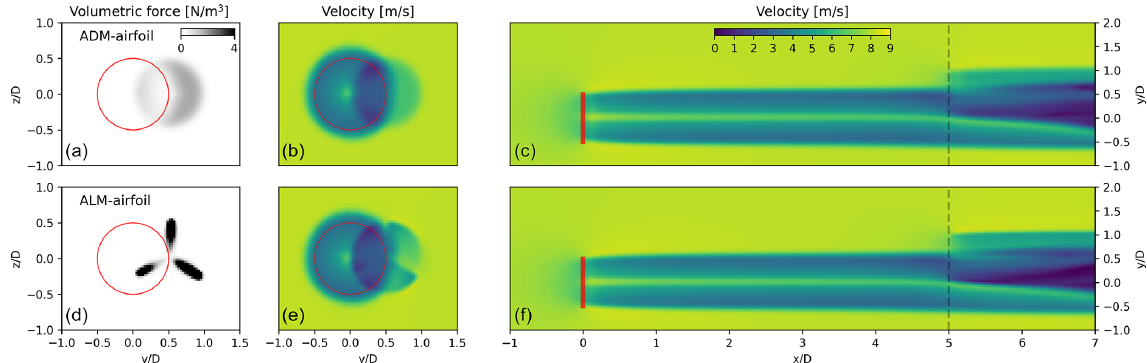
Figure 6. Model comparison for two turbines under uniform velocity inflow conditions of U ∞ = 8ms − 1 , using the ADM-airfoil in WT1 and testing the ADM-airfoil and the ALM-airfoil in WT2: instantaneous force (a, d) and velocity (b, e) in a vertical plane at the WT2 location. The WT1 rotor plane is marked by the red circle. (c, f) Instantaneous velocity in a horizontal plane at hub height, where the WT2 vertical plane position is marked with a dashed